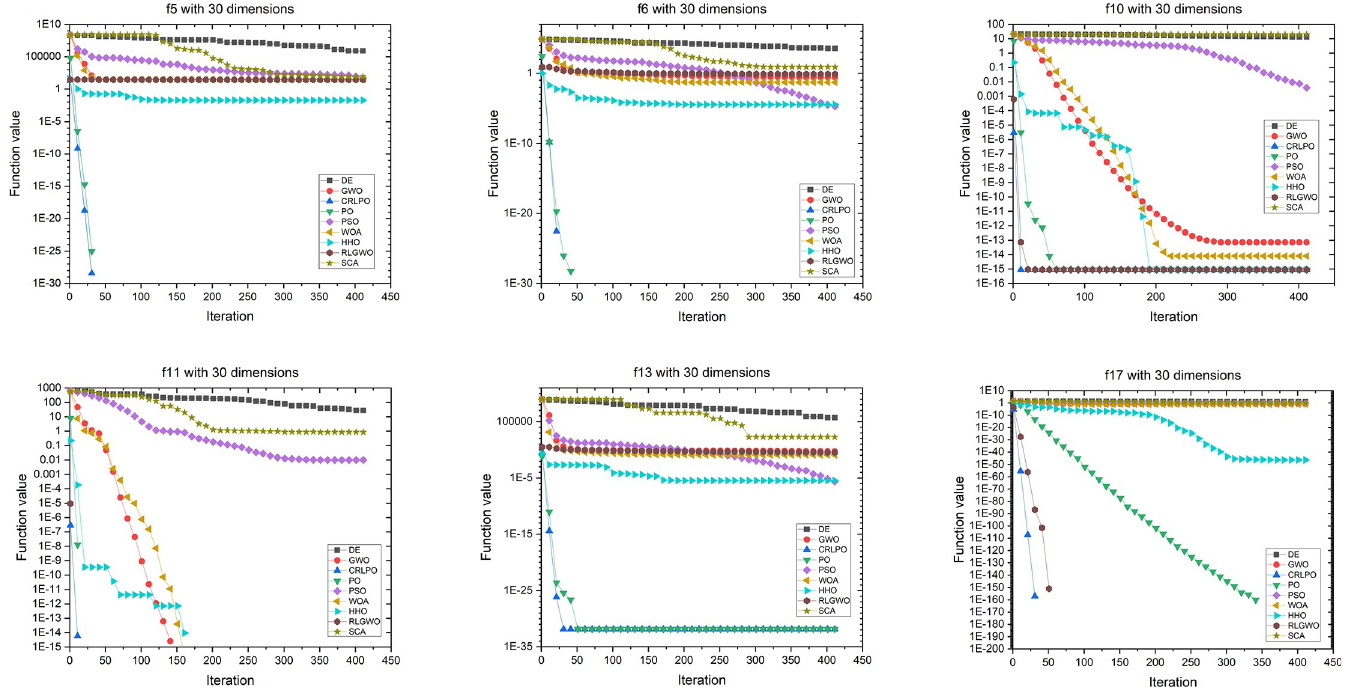
Fig 14. Convergence graph of CRLPO and eight other algorithms on six representative benchmark functions with 30 dimensions. https://doi.org/10.1371/journal.pone.0251204.g014 PLOS ONE | https://doi.org/10.1371/journal.pone.0251204 May 6,